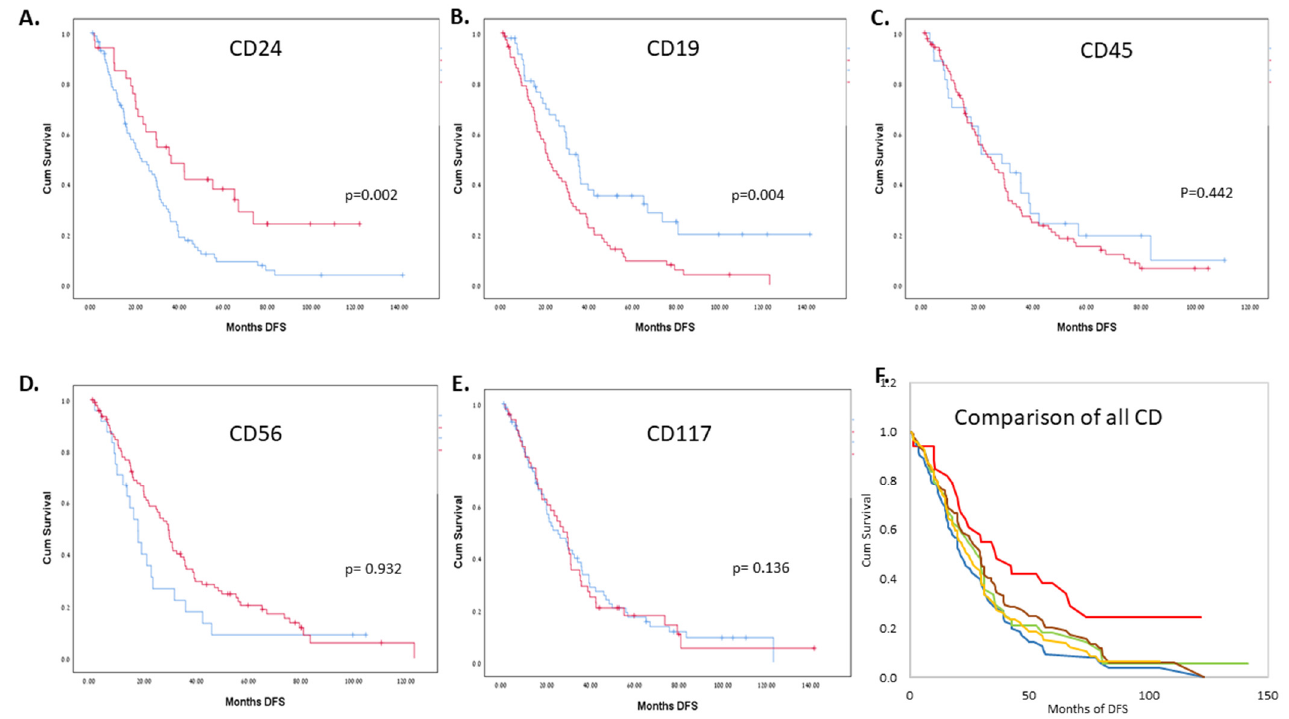
Figure 2. ( A – E ) Correlation of progression-free survival (PFS) to the CD levels measured by MFC at diagnosis, with a cutoff expression level of 5% on PCs (red above 5%, blue below 5%). ( F ) A visual comparison between the different CDs, pooled ( F ). All lines represent the expression of CD above 5%. CD24-red, CD117-brown, CD19-blue, CD45-yellow, CD56-green.